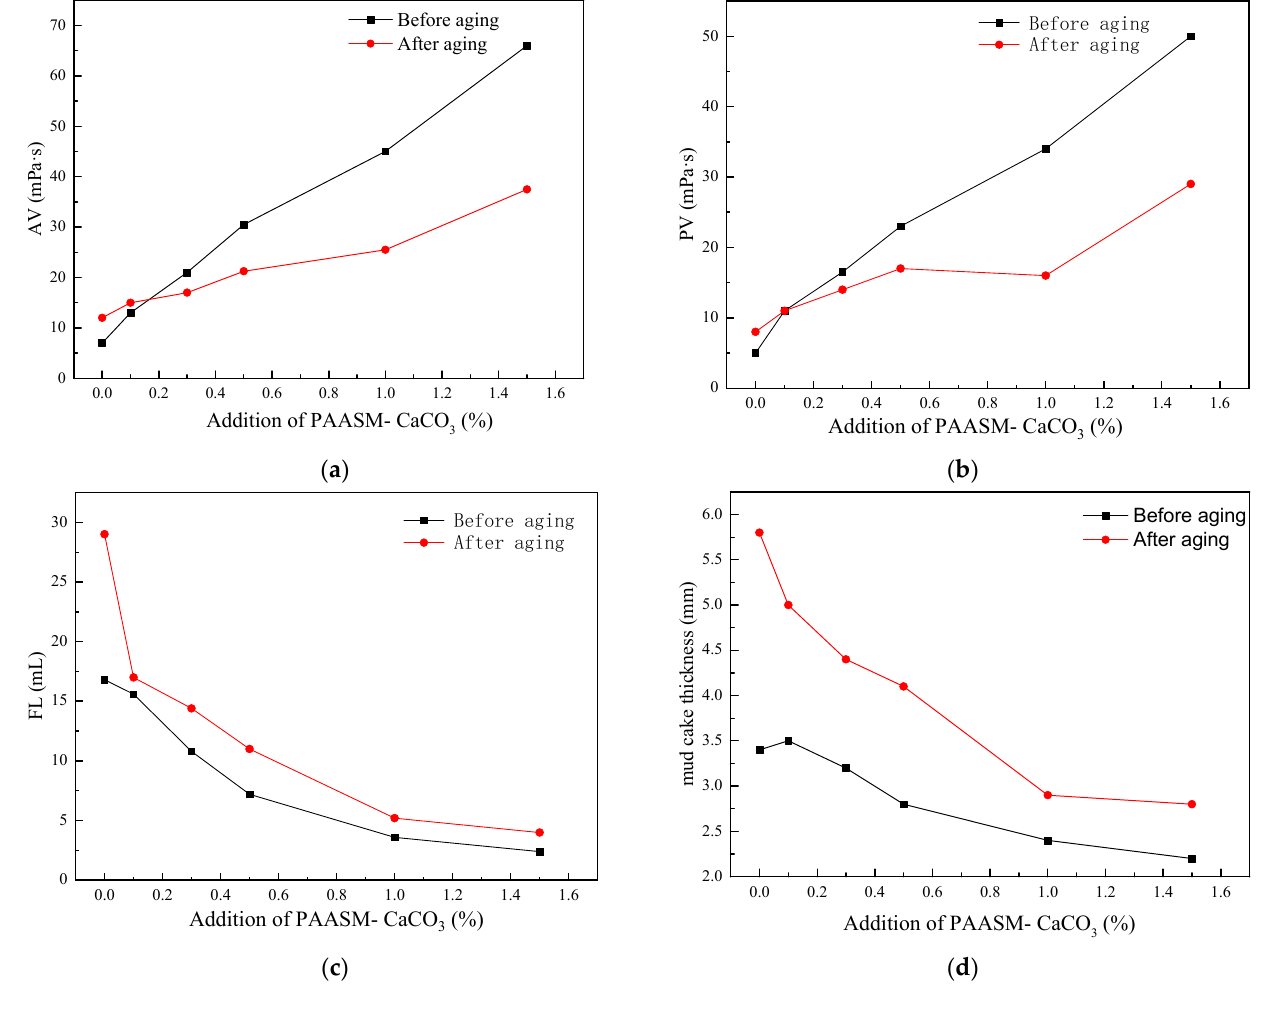
Figure 10. Effect of PAASM-CaCO 3 on rheological and filtration properties of 4% bentonite mud. ( a ) Apparent viscosity; ( b ) plastic viscosity; ( c ) filtration Volume; ( d ) mud cake thickness. It can be seen from the results that with the increase in PAASM-CaCO 3 content in 4% bentonite mud, AV, PV, and YP gradually increase. When 1.5% PAASM-CaCO 3 is added, the apparent viscosity of the slurry before and after aging is 66 MPa · s and 37.5 MPa · s, respectively, which indicates that PAASM-CaCO 3 still has a good tackifying effect after aging. In addition, the yield point of the pulp before and after aging is stable under different PAASM-CaCO 3 additions. It is also found that with the continuous addition of PAASM-CaCO 3 , the filtration loss of aging fluids decreases continuously. After aging at 200 °C/16 h, the filtration loss is 29 mL. Filtration loss is only 4 mL when 1.5% PAASM-CaCO 3 is added. At the same time, it is not difficult to see that with the increase in PAASM-CaCO 3 , the mud cake thickness of fluid becomes thinner gradually after aging, which indicates that the mud cake quality gradually improves and starts to become thinner and tougher, which indicates that the addition of PAASM-CaCO 3 can improve the colloidal high-temperature stability of drilling fluids.